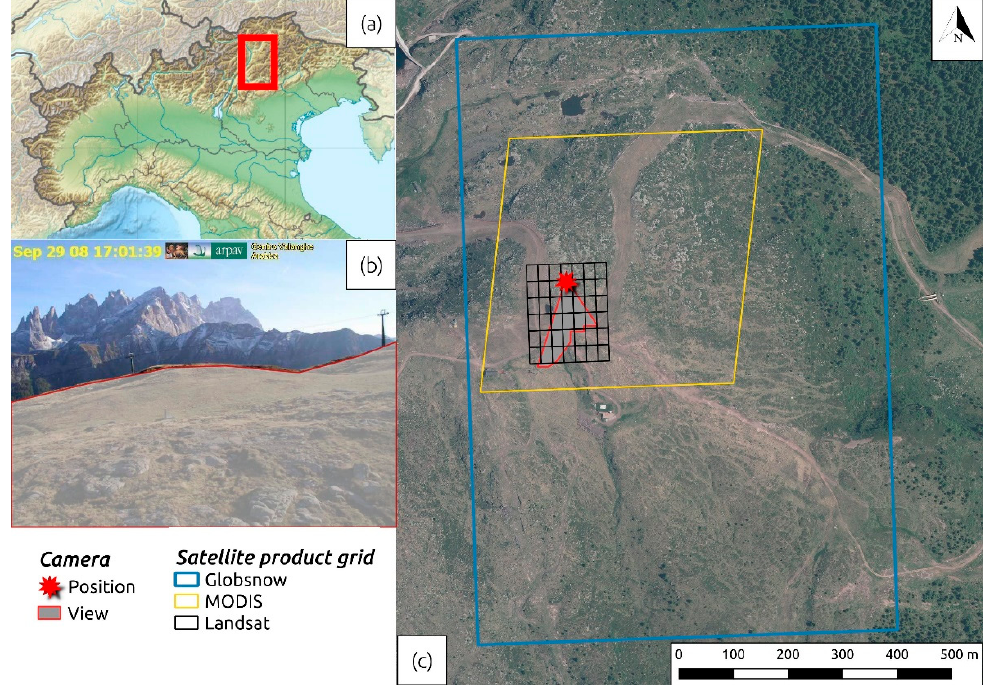
Figure 2. The study site of Cima Pradazzo ( a ), close to Falcade (Italy). Panoramic view of the camera ( b ) with the considered mask in red. The orthorectified views of the camera ( c ): the grey shaded area with red contour shows the camera view projected on the ground; and the colored lines indicate the pixel grids of the different satellite products.